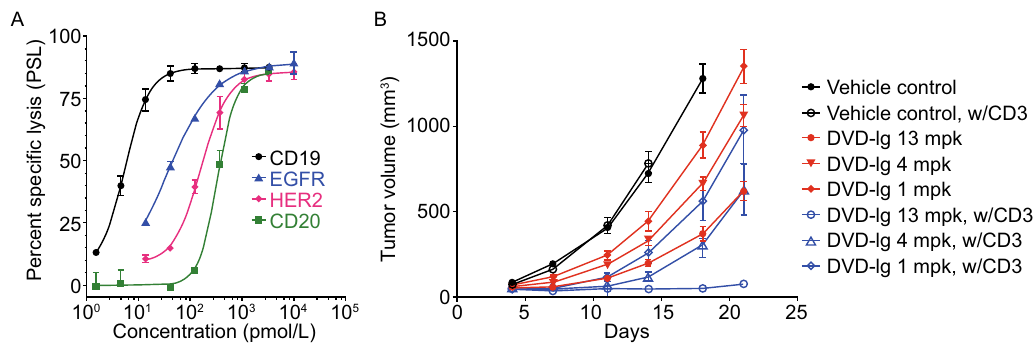
Figure 1. DVD-Ig molecules elicit redirected T cell killing in vitro and in vivo . (A) In vitro CD19( ● ), CD20( ■ ), EGFR( ▲ ), HER2( ♦ ) rCTL activity on RAJI (CD19, CD20), A431 (EGFR), and N87 (HER2) target cells were measured by cellular impedance assay. (B) In vivo tumor growth kinetics using A431 xenograft mouse model with dose titration of a CD3-EGFR DVD-Ig molecule (1 mpk, 4 mpk, or 13 mpk) with or without the addition of CD3-positive